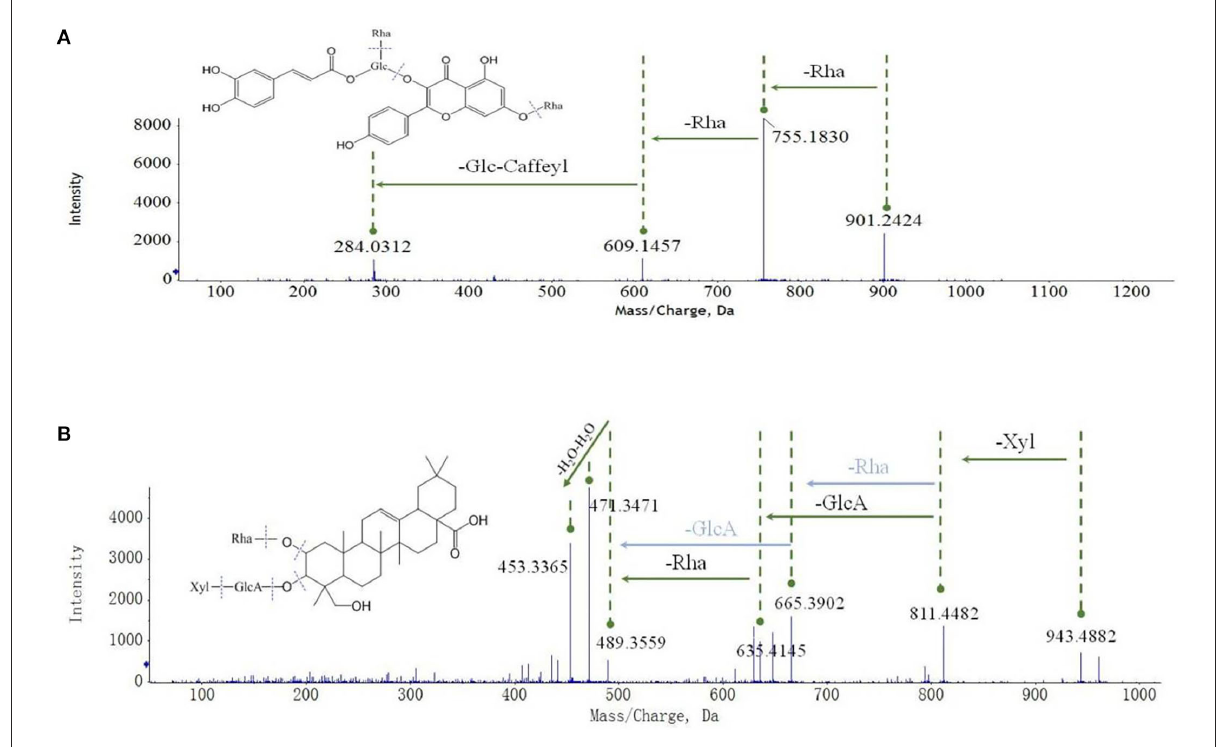
FIGURE3 Mass spectrum cleavage law of flavonoids and saponins [ (A) flavonoids; (B)